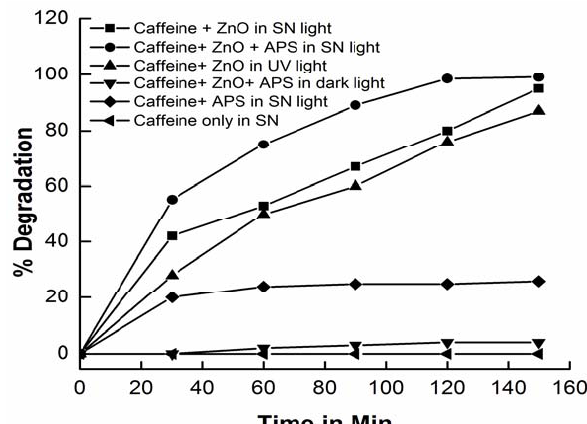
Fig. 4. Effect of sunlight, and dark light on the degradation of Caffeine